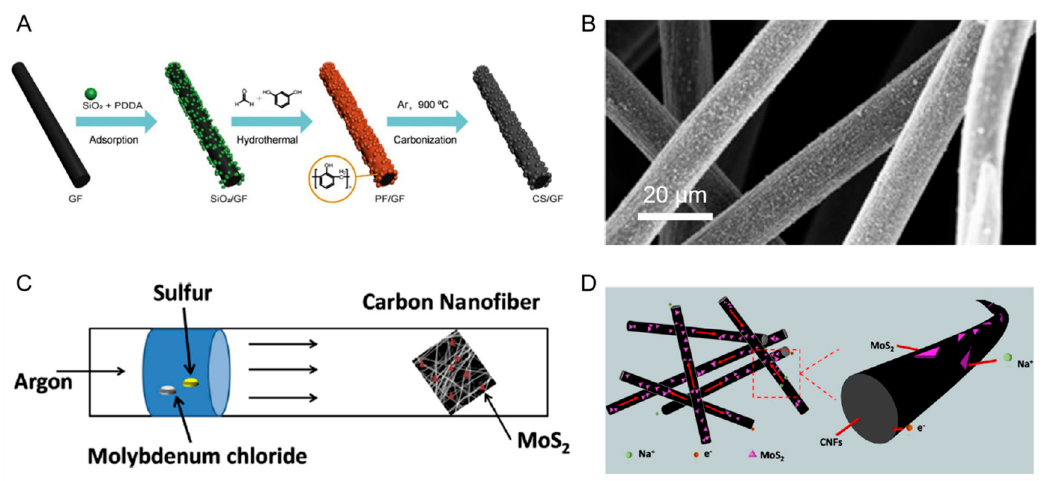
Figure 2. ( A ) Fabrication method of Carbon Sphere(CS)/glass fabric (GF) electrode. ( B ) SEM image of CS/GF electrode. Reproduced with permission from [17]. ( C ) Schematic depiction of the method of CNF composite. ( D ) Pictorial representation of sodium storage mechanism in MoS2@CNFs. Reproduced with permission from [19].